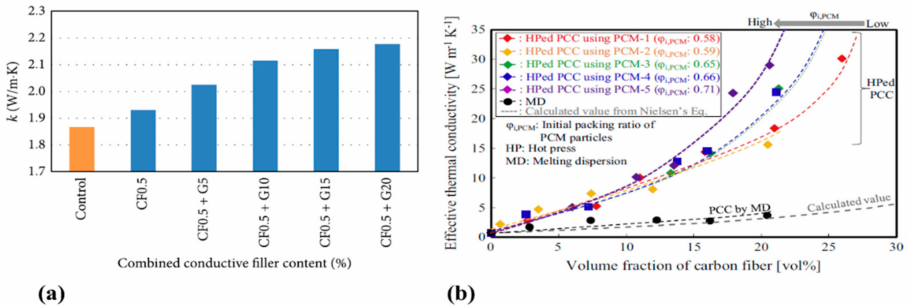
Figure 11. ( a , b ) shows the thermal conductivity enhancement by increasing CF content in different CF based composites. Reprinted with permission from [90,91]. Copyright 2015 Bai et al. and Elsevier